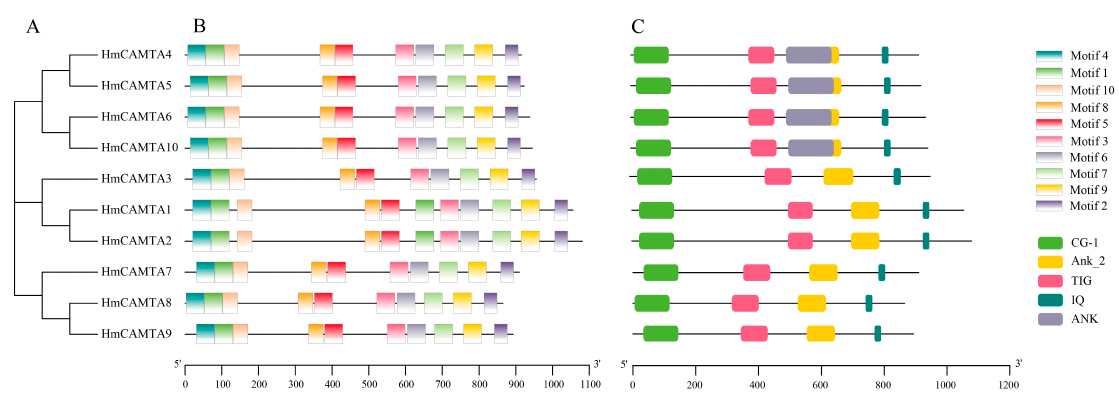
Figure 2. Phylogenetic tree ( A ), protein motif structure ( B ) and domain ( C ) analysis of HmCAMTA gene family. And the modules of different colors represent different motifs or domains.